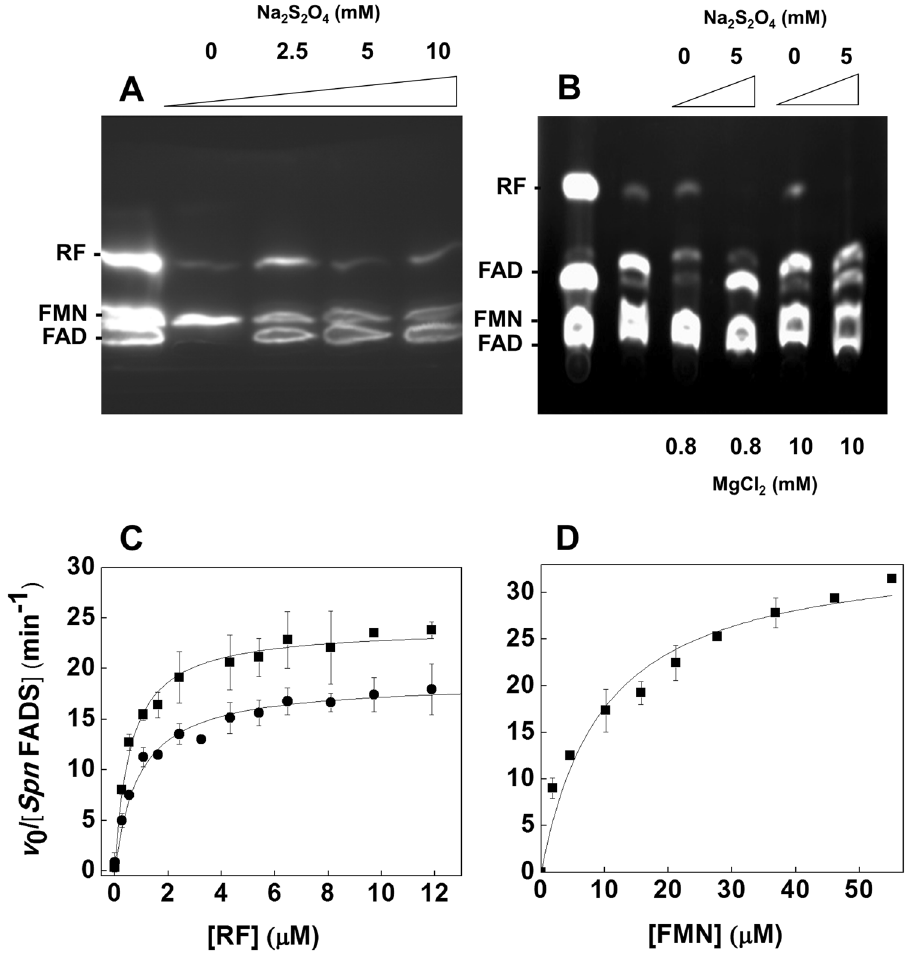
Figure 1. The RFK, FMNAT and FADpp activities of Spn FADS. ( A ) Thin layer chromatography of the products of the RFK and FMNAT activities. Reaction mixtures contained around 500 nM Spn FADS, 50 μ M RF, 0.2 mM ATP, and several concentrations of sodium dithionite. First lane to the left corresponds to a standard solution containing RF, FMN and FAD at 50 μ M each. ( B ) Thin layer chromatography of the products of FADpp activity. Reaction mixtures contained around 500 nM Spn FADS, 50 μ M FAD, 0.2 mM PPi, and several concentrations of sodium dithionite. First lane corresponds to the standard solutions and second line to a free FAD sample with 10 mM MgCl 2 . ( C ) Rates for RFK activity as a function of the RF concentration at saturating ATP (412 μ M) without ( ● ) and with 2.6 mM ( ■ ) sodium dithionite. ( D ) Rates for the FMNAT activity as a function of the FMN concentration at saturating ATP (252 μ M) and 3 mM sodium dithionite. Unless otherwise stated all measurements were carried out at 25 °C in 20 mM PIPES, pH 7.0, with 0.8 mM MgCl 2